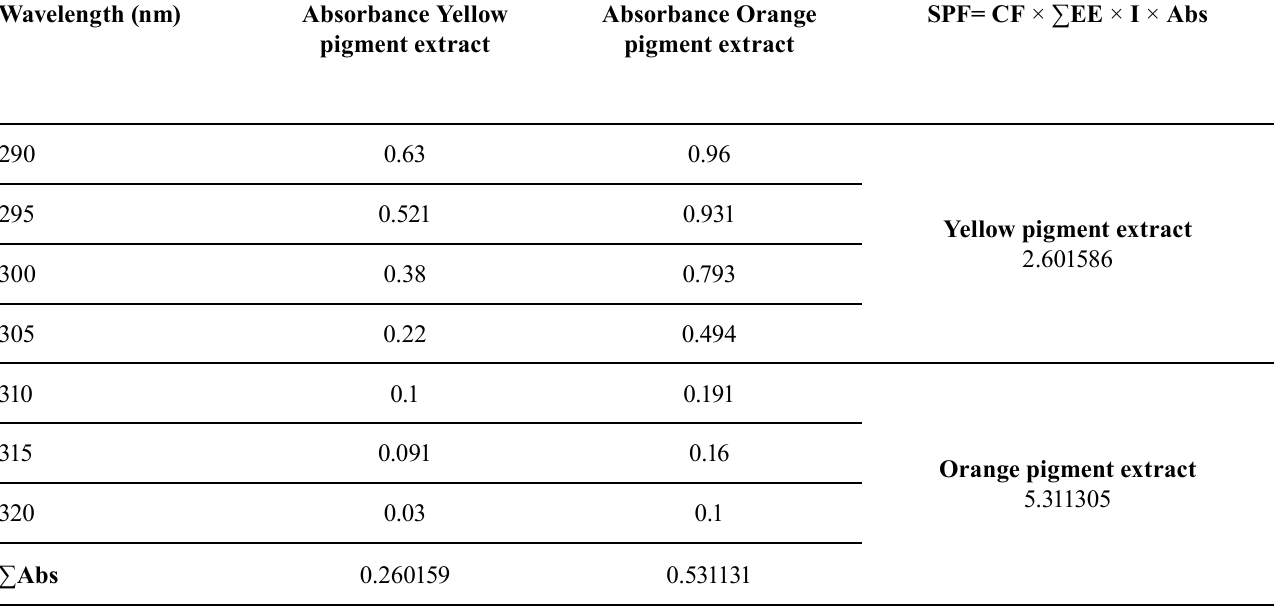
TABLE IV – Sun Protection Factor (SPF) of the two pigment extracts as calculated by the Mansur